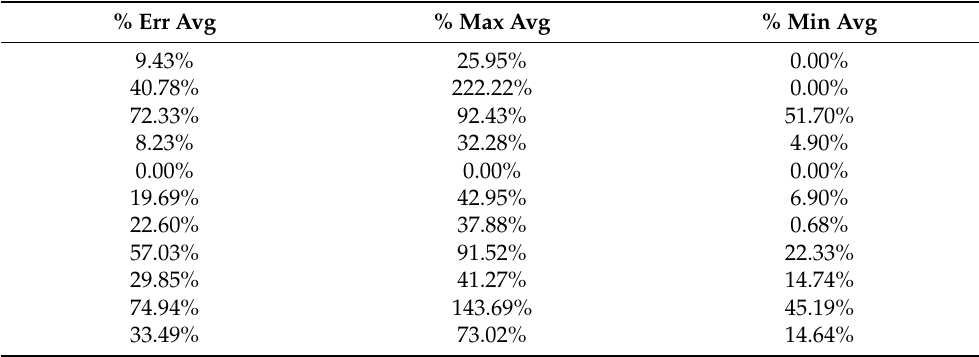
Table A165. Set 3, trials 1–10 data (single 0.5 PR